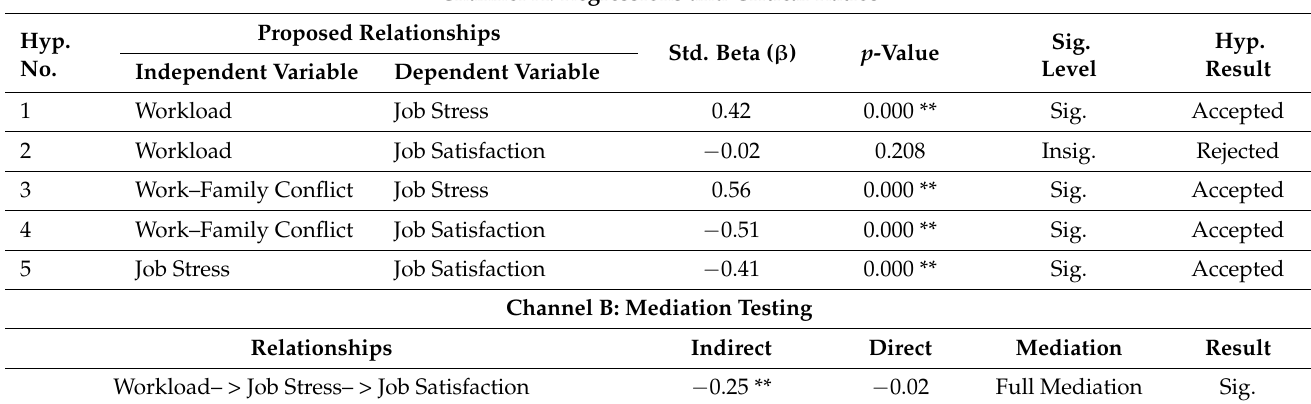
Table 7. Critical ratios and hypotheses summary. Channel A: Regressions and Critical